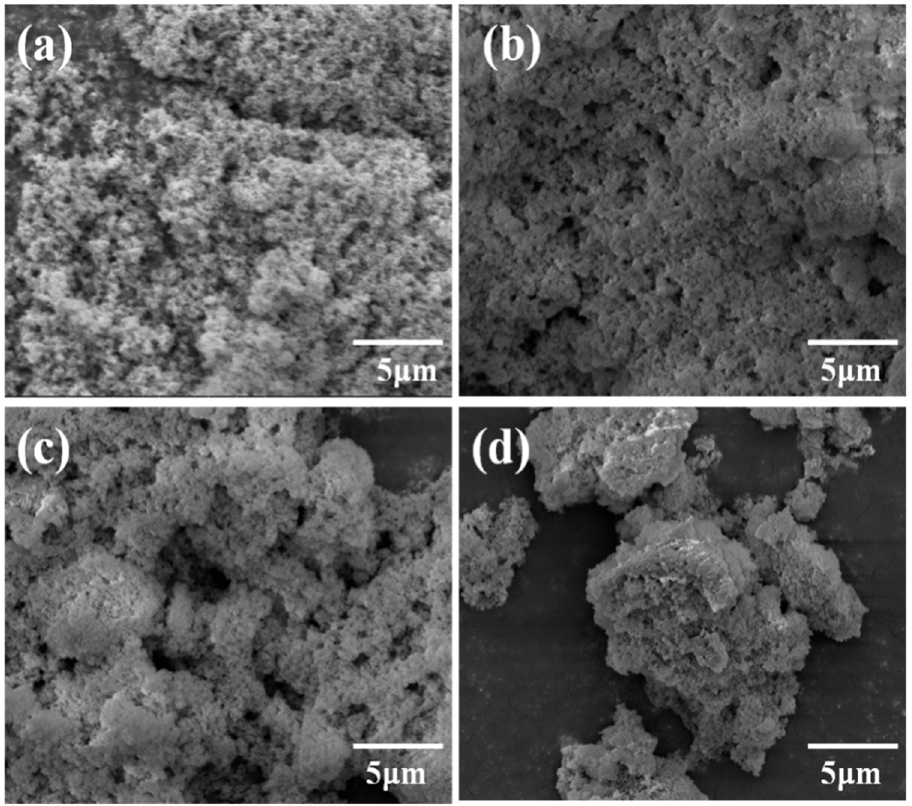
Figure 4. SEM images of MCTO-400 ( a ), MCTO-500 ( b ), MCTO-600 ( c ), and MCTO-700 ( d ).